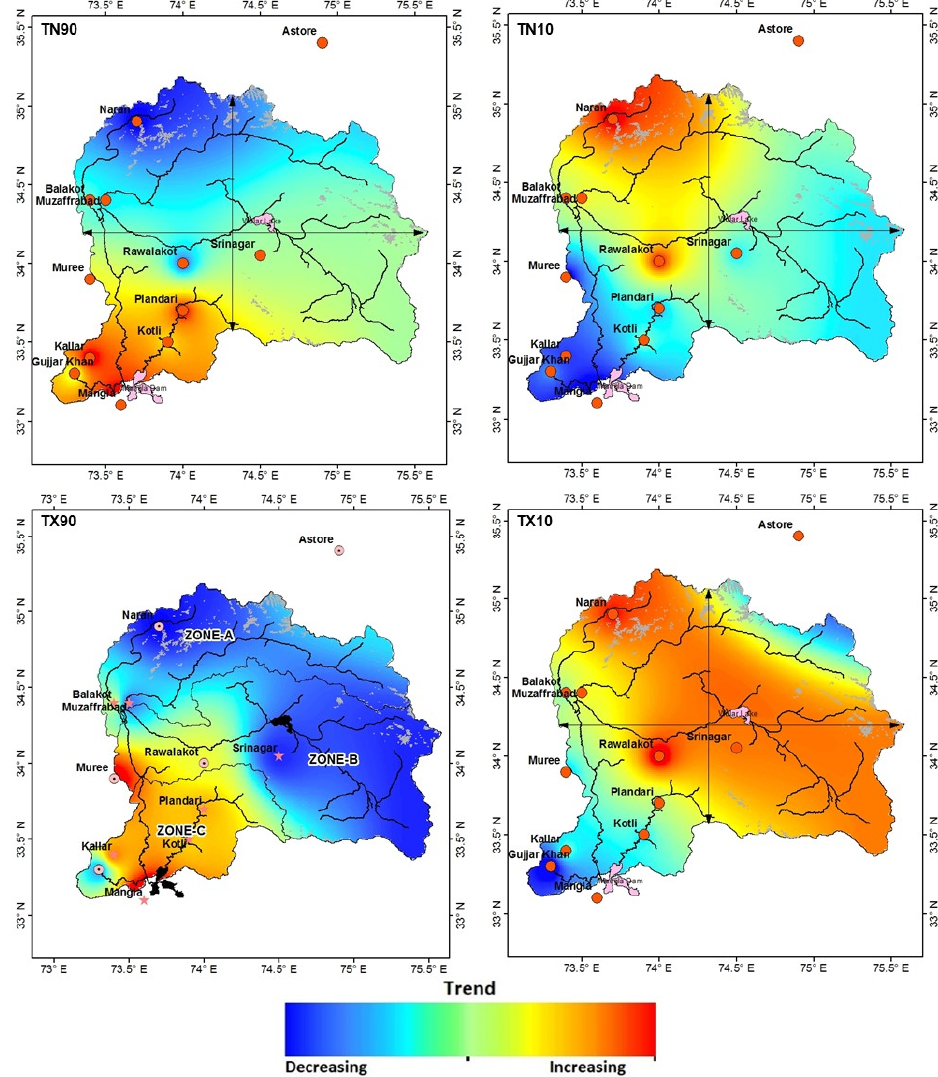
Figure 5. Spatial Trends of Percentage of warm nights (TN90), Percentage of cold nights (TN10), Percentage of warm days (TX90), Percentage of cold days (TX10). Table 6. Relative temperature indices slopes and trends.